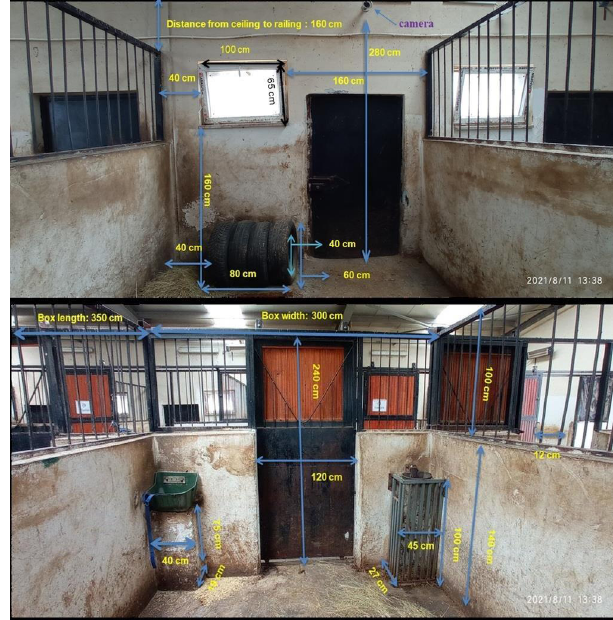
Figure 1. The box stall used in the